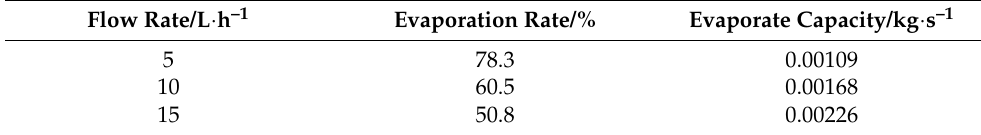
Table 2. Effect of nozzle air flow on evaporation rate and capacity (P = 0.1MPa, T = 70 ◦